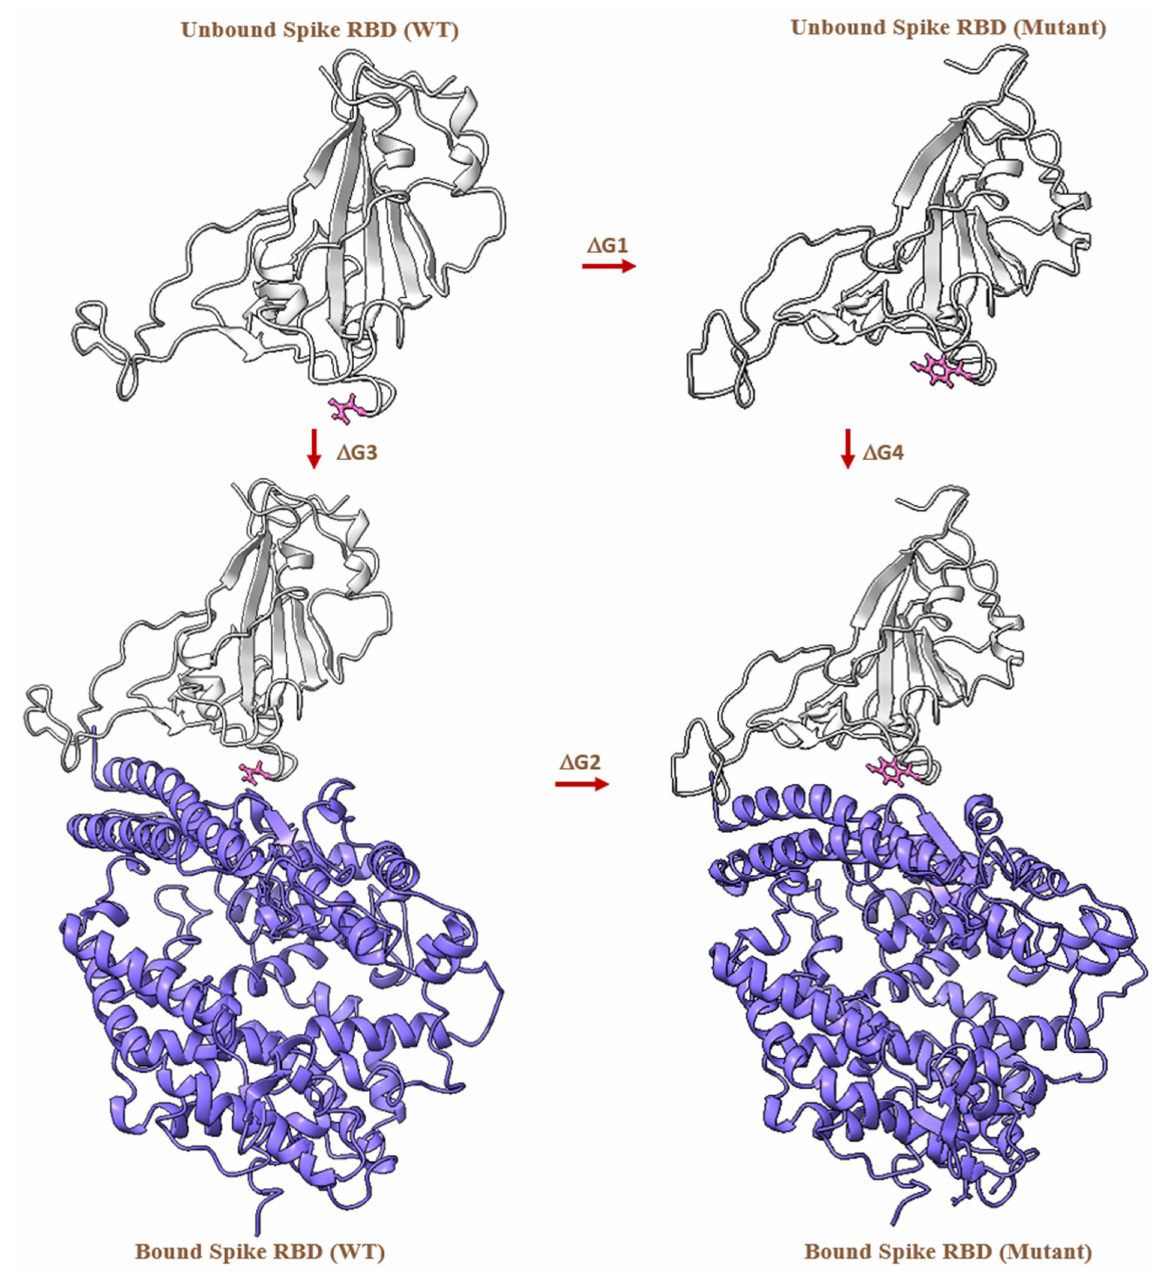
Figure 8. Alchemical free energy cycle represented for the SARS-CoV-2 spike RBD (WT and mutant) in an unbound and bound state with hACE2. The arrows indicate the free energy cycle. Asn-501 in WT and Tyr-501 in the mutant structure are shown in pink ball and stick representation, spike RBD in gray and hACE2 in purple cartoon representation. (The free energy cycle is repeated in same way for all the other